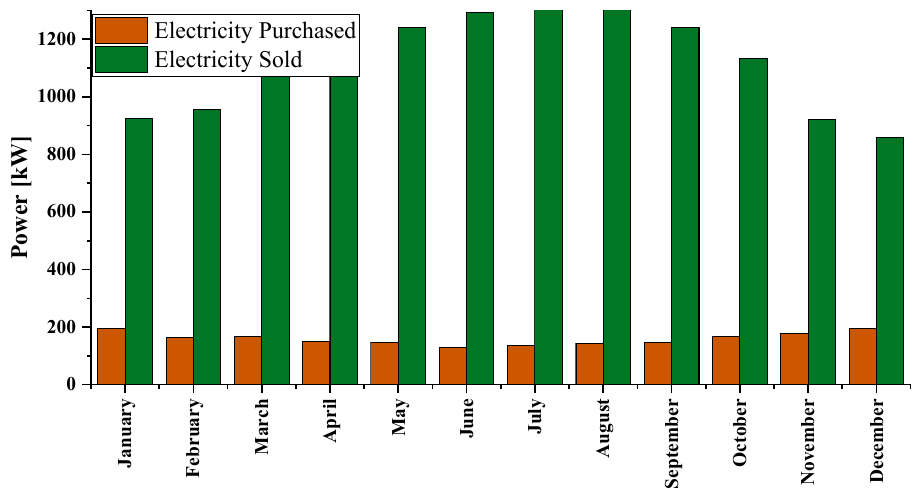
Figure 12. Average monthly purchased/sold power from/to utility grid. Table 5. Grid emission productions over the optimization